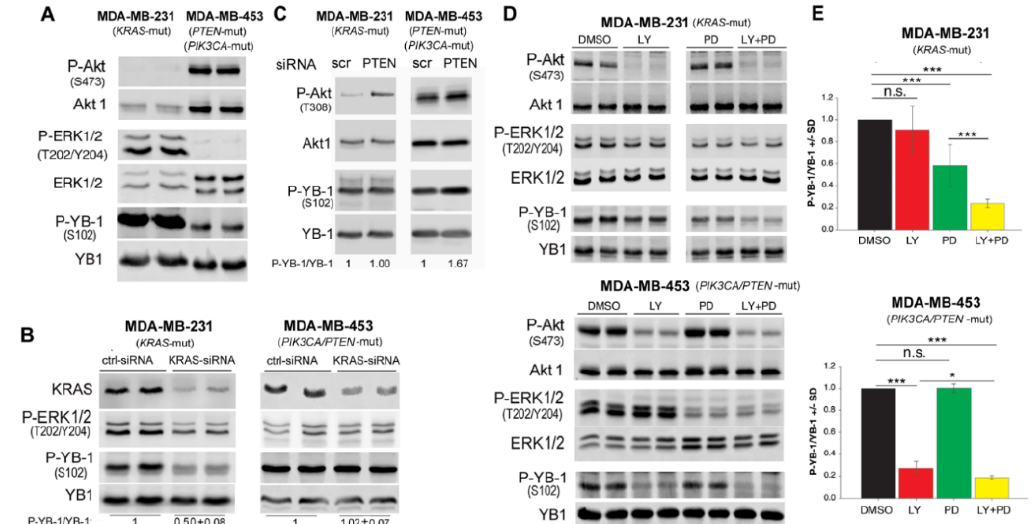
Figure 2. S102 phosphorylation of YB-1 is differentially affected by the MAPK pathway and PI3K in KRAS -mutated MDA-MB-231 and PIK3CA / PTEN -mutated MDA-MB-453cells. ( A ) Protein samples from 2 parallel cultures were isolated, and the basal phosphorylation levels of AKT, ERK1 / 2 and YB-1 were detected by Western blotting. Blots were stripped and incubated with antibodies against total proteins. ( B , C ) Cells were transfected with control-siRNA (ctrl-siRNA), KRAS -siRNA or PTEN -siRNA. Protein samples were isolated at seventy-two hours after transfection ( B ) and 48 h after transfection ( C ). The indicated phospho- as well as total proteins were detected by Western blotting. The densitometry analysis shows the mean ratio of P-YB-1 / YB-1 ± SD ( n = 4 data from 2 independent experiments) ( B ), normalized to 1 in ctrl-siRNA conditions ( B , C ). ( D ) Indicated cells were treated with the PI3K inhibitor LY294002 (LY, 10 µ M), MEK inhibitor PD98059 (PD, 20 µ M), or a combination of LY and PD for 2 h and protein samples were isolated. Protein samples exposed to the same treatment conditions were isolated from 2 parallel cultures. The indicated phospho- as well as total proteins were detected by Western blotting. ( E ) Densitometry values represent the mean P-YB-1 / YB-1 ratio normalized to 1 in the DMSO-treated condition (MDA-MB-231: n = 6 data from 3 independent experiments; MDA-MB-453: n = 4 data from 3 independent experiments). (* p < 0.05, *** p < 0.001, Student’s t -test), n.s.: not significant.